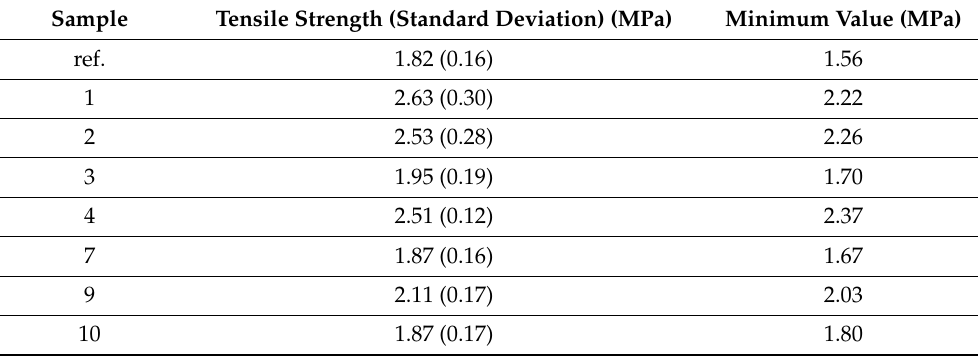
Table 3. Tensile strength by the pull-off